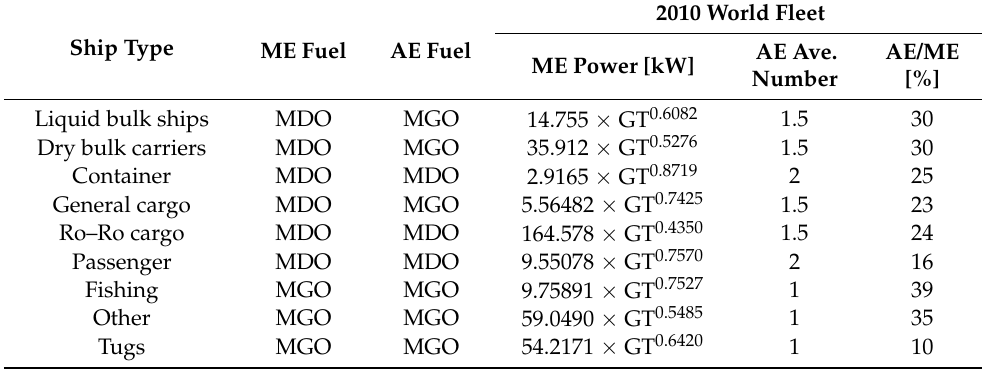
Table 3. Load assumption of MCR for hoteling [%]. Ship Activity